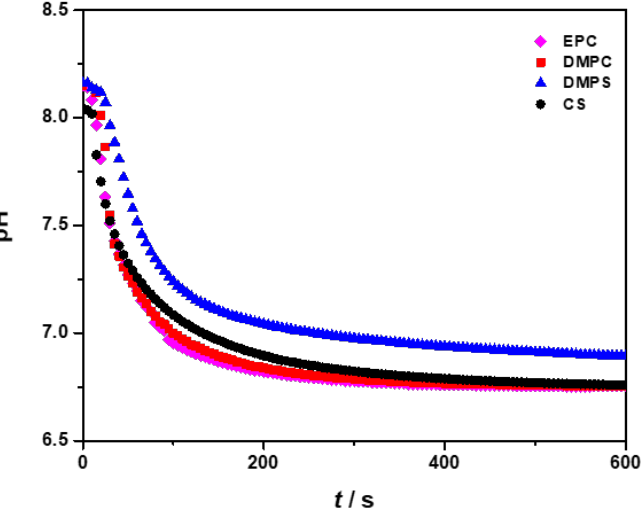
Figure 5. Representative pH vs. time curve during CaCO 3 precipitation in the absence (CS) and presence of different lipids. c i (Ca) = c i (CO 3 ) = 20 mmol dm − 3 . γ (lipid) = 25.0 ppm; pH i = 8.15; ϑ /°C = 25 ± 0.1.